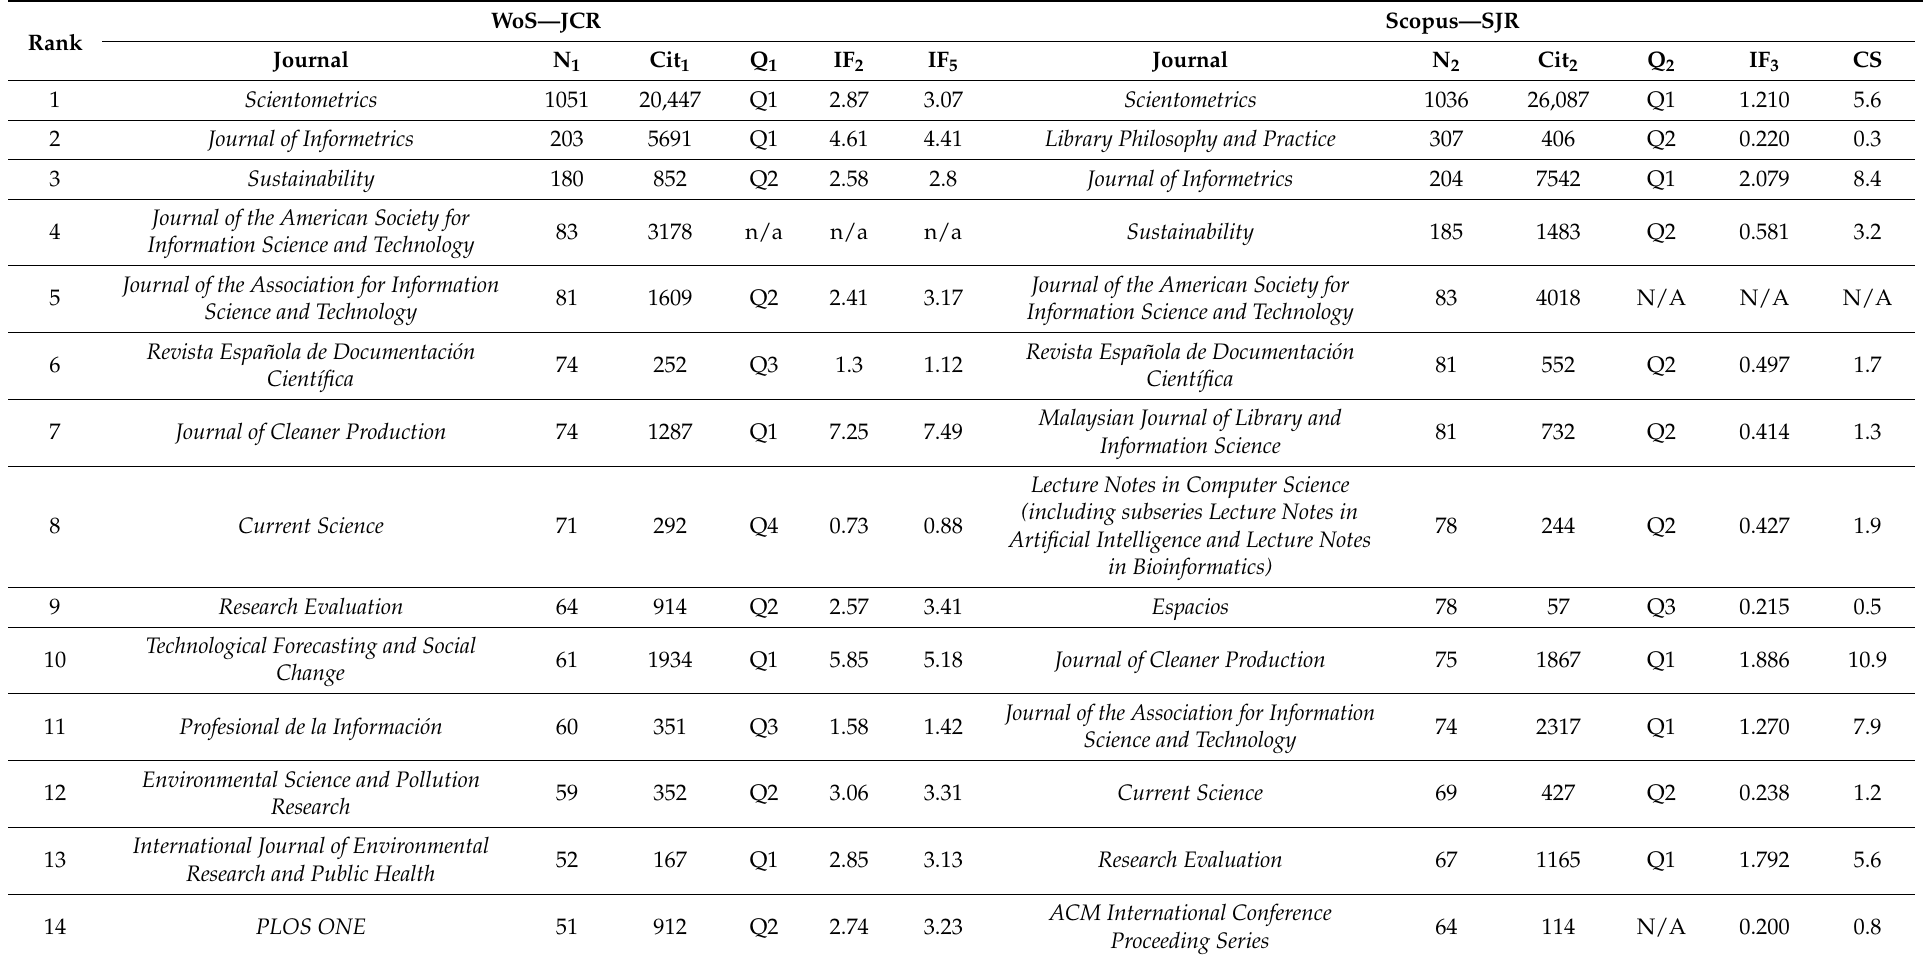
Table 8. Main indexes of WoS-JCR and Scopus-SJR bibliometric